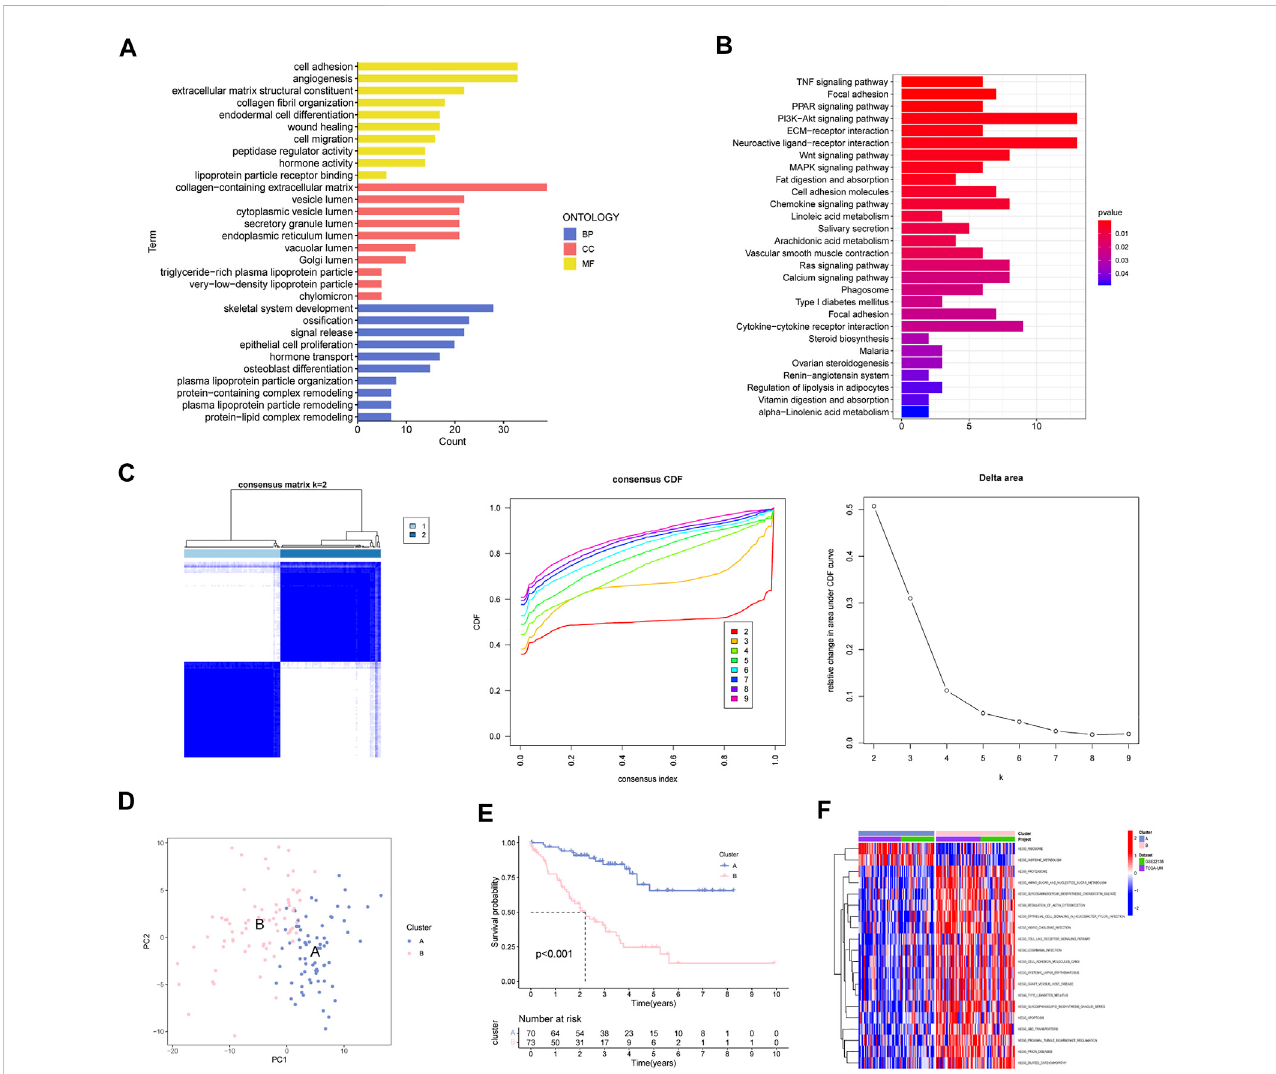
FIGURE 2 Determination of MAGs-based Molecular Subtype in UM. (A) GO analysis, (B) KEGG enrichment and (C) Consensus clustering analysis of MAGs. (D) PCA, (E) survival analysis and (F) GSVA analysis of two